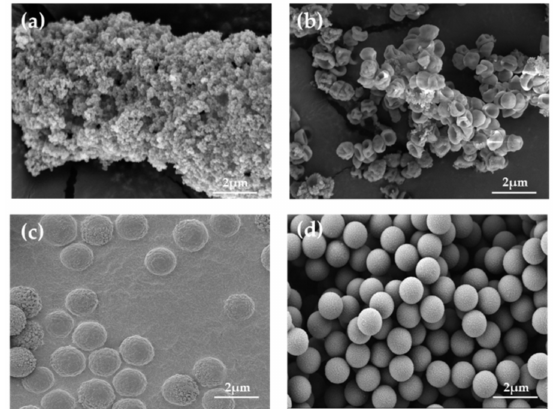
Figure 6. SEM image of polymer shape, depending on the amount of THF remaining in the material: ( a ) composite image of material with THF 9.64 wt%, ( b ) composite image of material with THF 3.15 wt%, ( c ) composite image of material with THF 0.03 wt%, and ( d ) composite image of material with THF 0